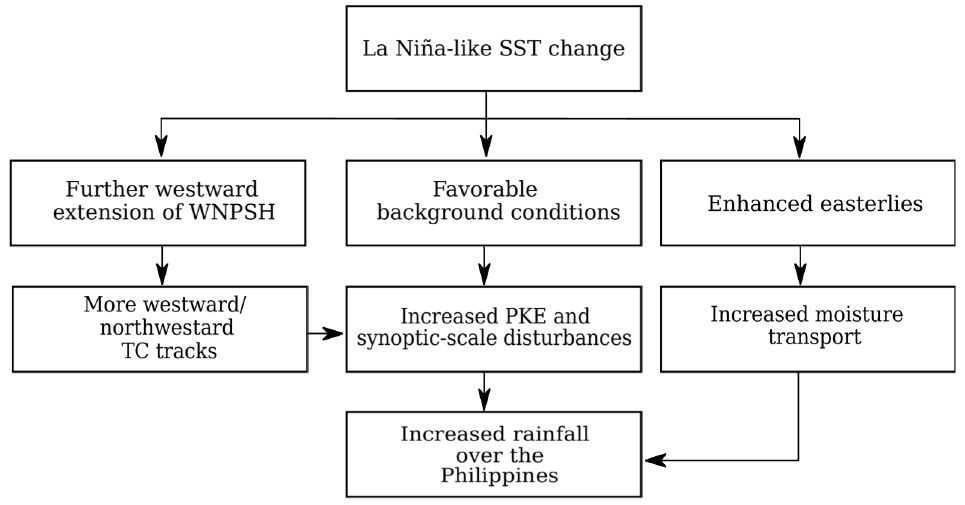
Figure 12 . As in Figure 11 but for the increase in rainfall during E3 (1993 2008). WNPSH: western North Pacific Subtropical High.